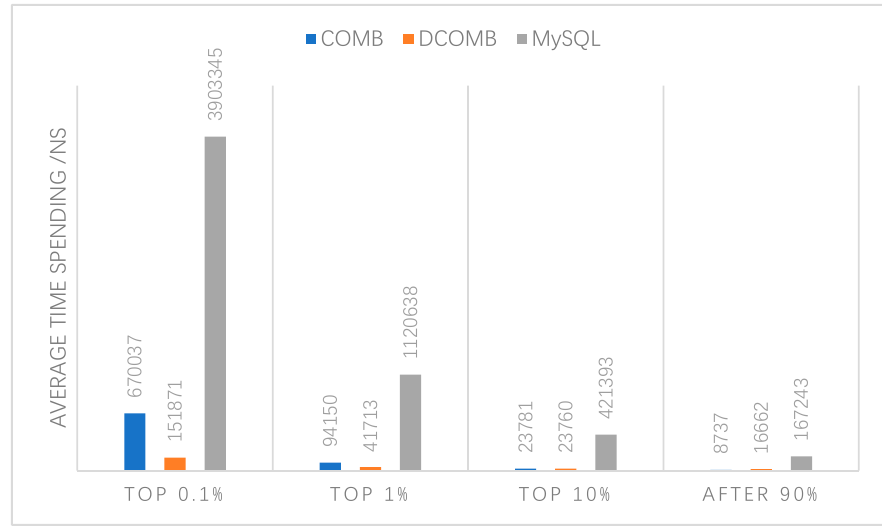
Figure 13. COMB, DCOMB and MySQL comparison.